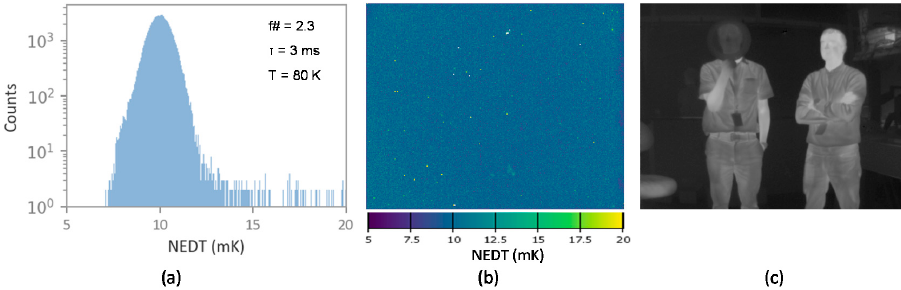
Figure 7. ( a ) Noise-equivalent temperature difference (NEDT) histogram of a 320 × 256 focal plane array (FPA) at 80 K; ( b ) NEDT operability map; and ( c ) an image taken at 80 K with f/2.3 optics and a 3 ms integration time.